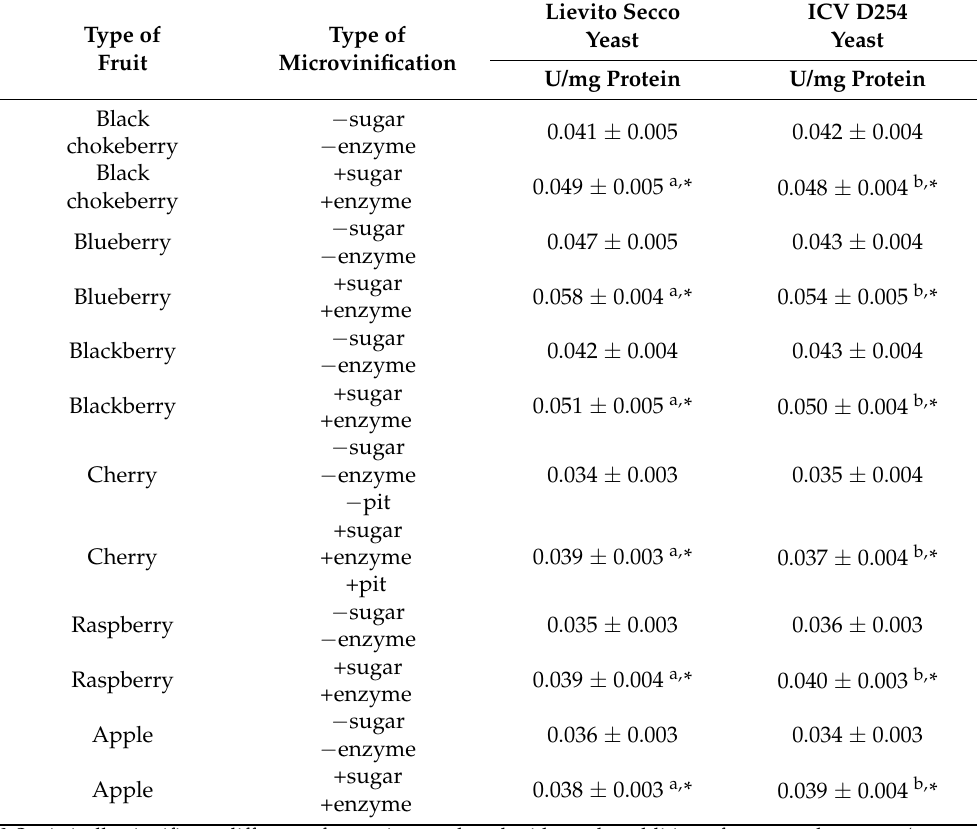
Table 2. Specific activities of catalase (U/mg protein) in wine-treated synaptosomes with H 2 O 2 -induced oxidative stress obtained for different types of fruit wines and microvinification. Type of Type Fruit